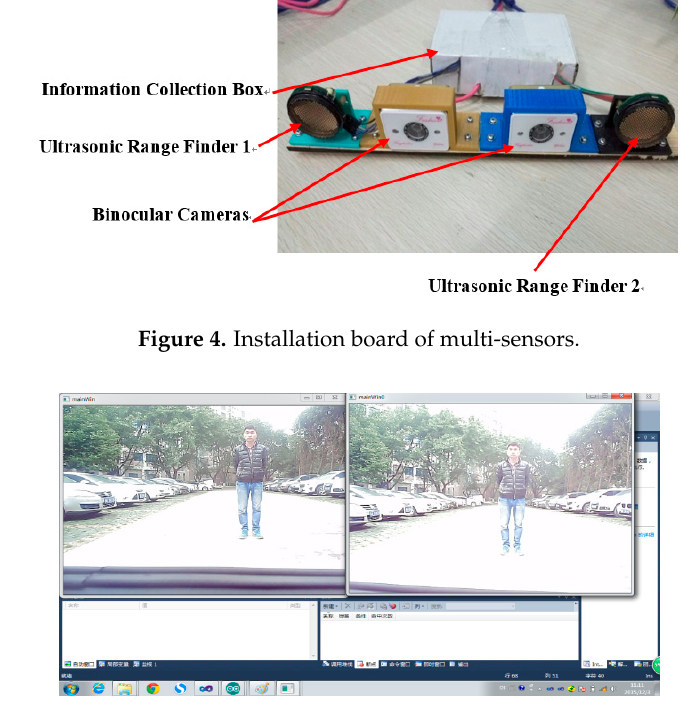
Figure 5. The results of binocular cameras when a vehicle is reversing.